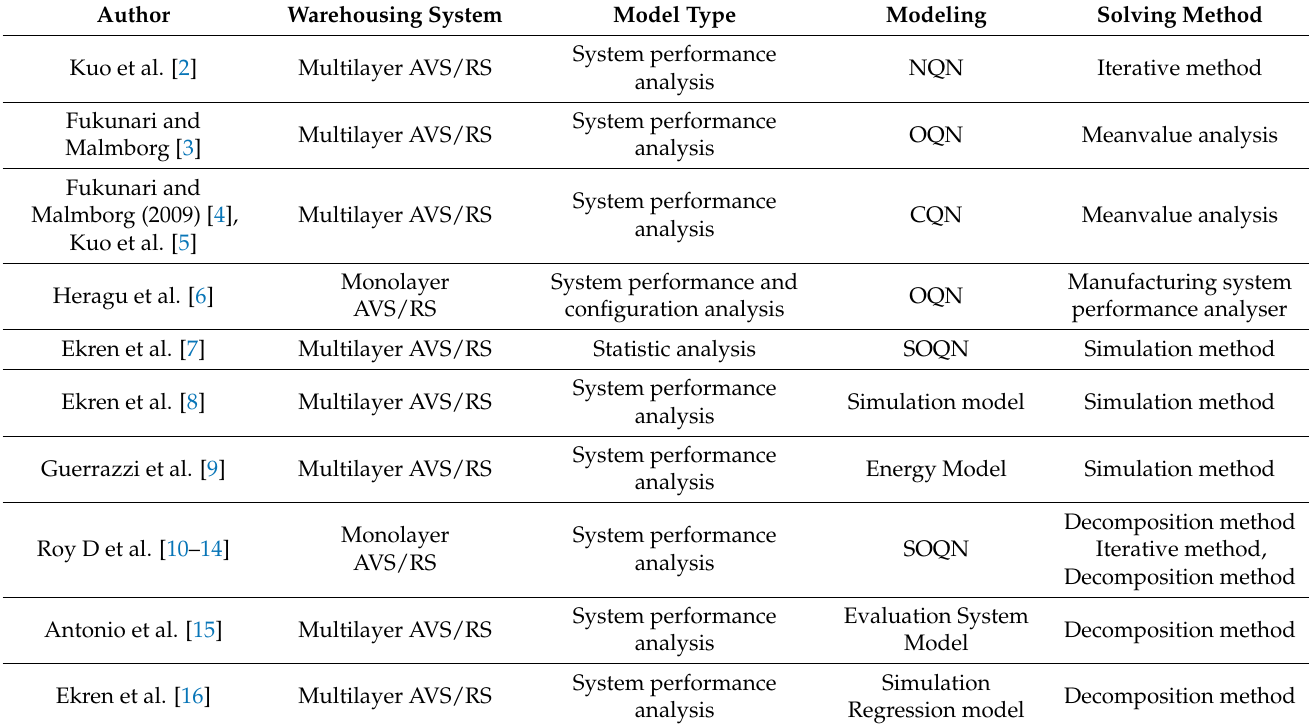
Table 1. Summary of research on AVS/RS